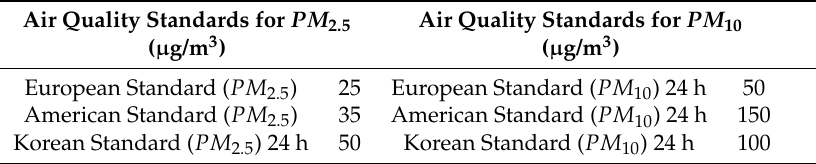
Table 4. Region-wise air quality standards for particulate matters ( PM 2.5 and PM 10 ).